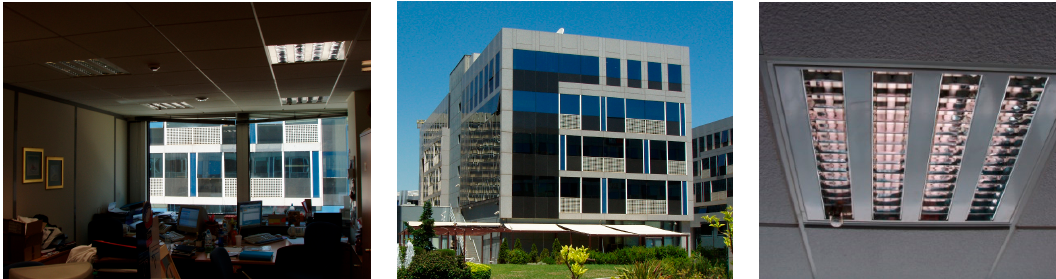
Figure 3. Interior space ( left ), exterior façade ( middle ) and position of the photosensor ( right ) for Building B.